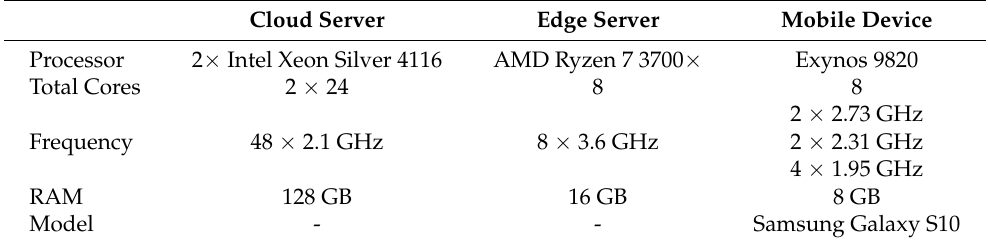
Table 1. Processing resources characteristics used in